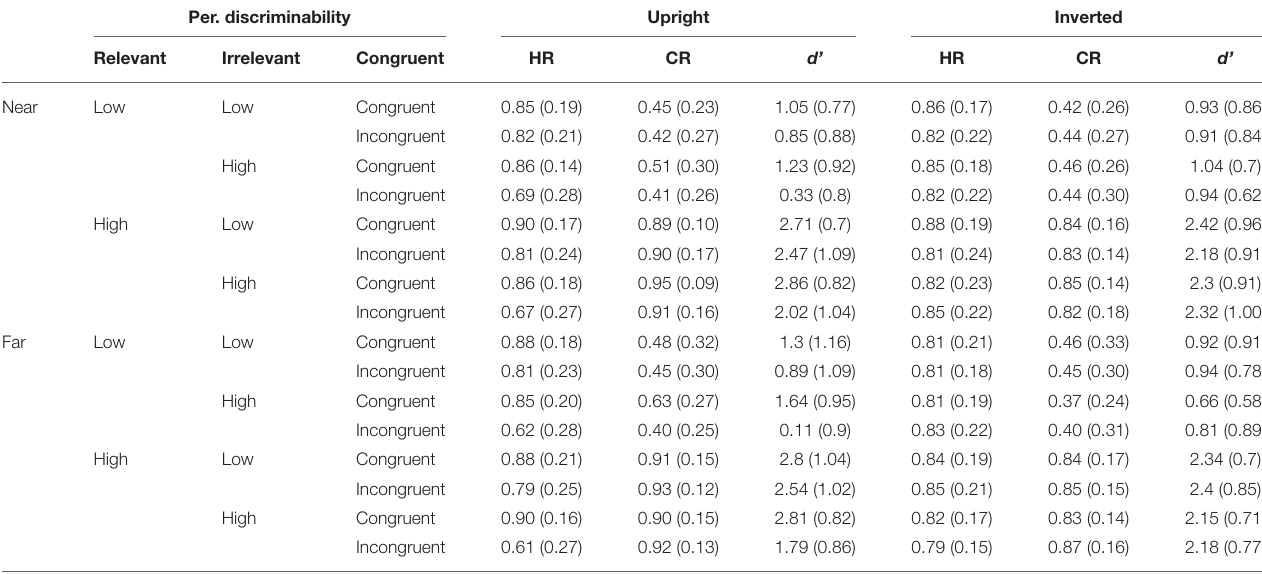
TABLE 3 | Mean hit rate (HR) and correct rejection rate (CR) as a function of the conditions manipulated in Experiment 2 ( N = 23) (standard deviations are shown in parentheses).